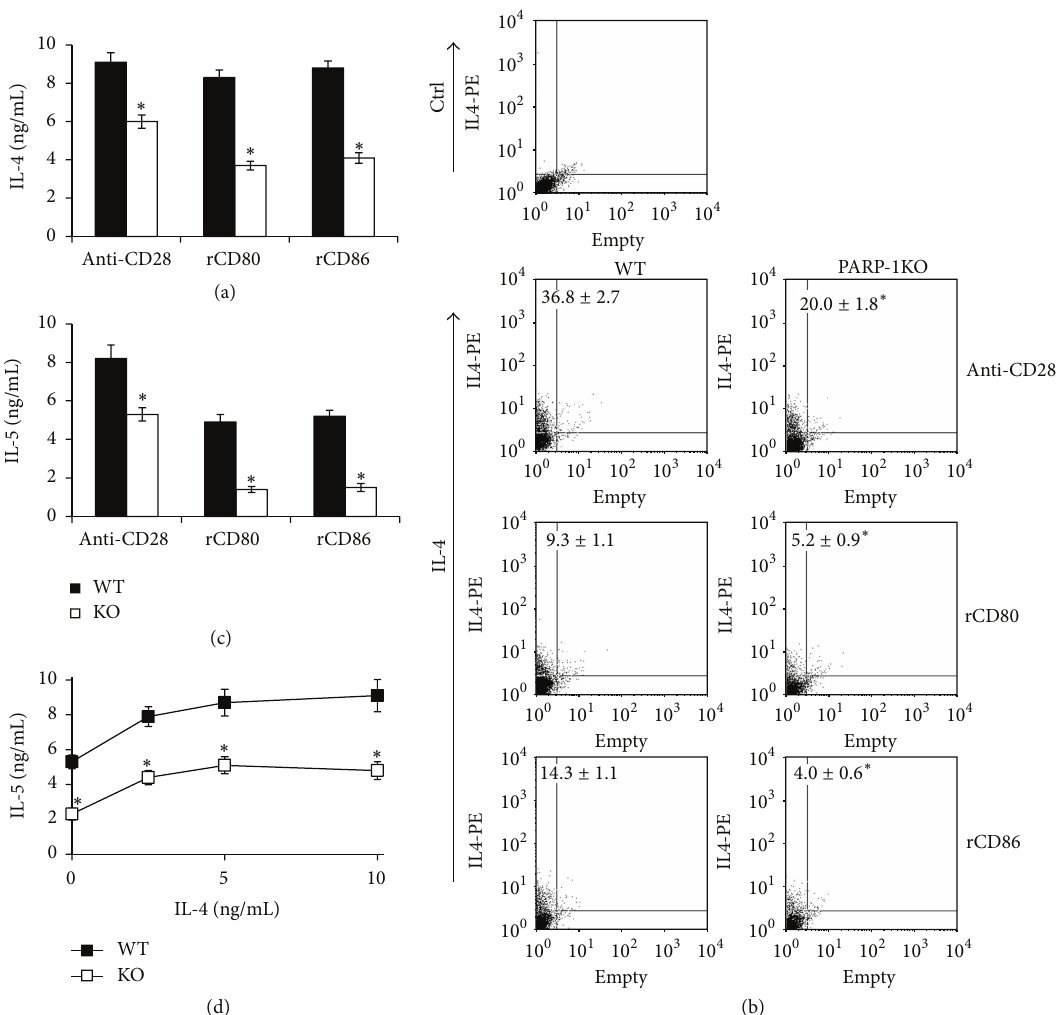
Figure 1: PARP-1 deficient cells display impaired Th2 cell polarization. Na¨ıve CD4 T cells from wild type (WT, filled symbols) and PARP-1KO (KO, unfilled symbols) mice were stimulated with anti-CD3 mAb and either anti-CD28 mAb or recombinant CD80 or rCD86. (a) and (c) After 7 days of stimulation, culture supernatants were collected and analyzed by ELISA to assess IL-4 and IL-5 concentrations. (b) After 7 days of stimulation, cells were collected, restimulated with PMA and ionomycin for 6 hours in the presence of brefeldin A, and analyzed by flow cytometry to assess the frequency of IL-4-producing cells. Representative dot plots are shown. Numbers represent mean percentages of IL-4 + cells ± S.E.; ctrl, control antibody. (d) Culture supernatants from cells stimulated with anti-CD3 and rCD86 in the presence of graded concentrations of IL-4 (0–10ng/mL) were analyzed for IL-5 by ELISA. Values represent means ± S.E. Results were confirmed in three other independent experiments. ∗ 𝑃 < 0.05 for KO versus WT cells in (a), (b), (c), and (d) panels.